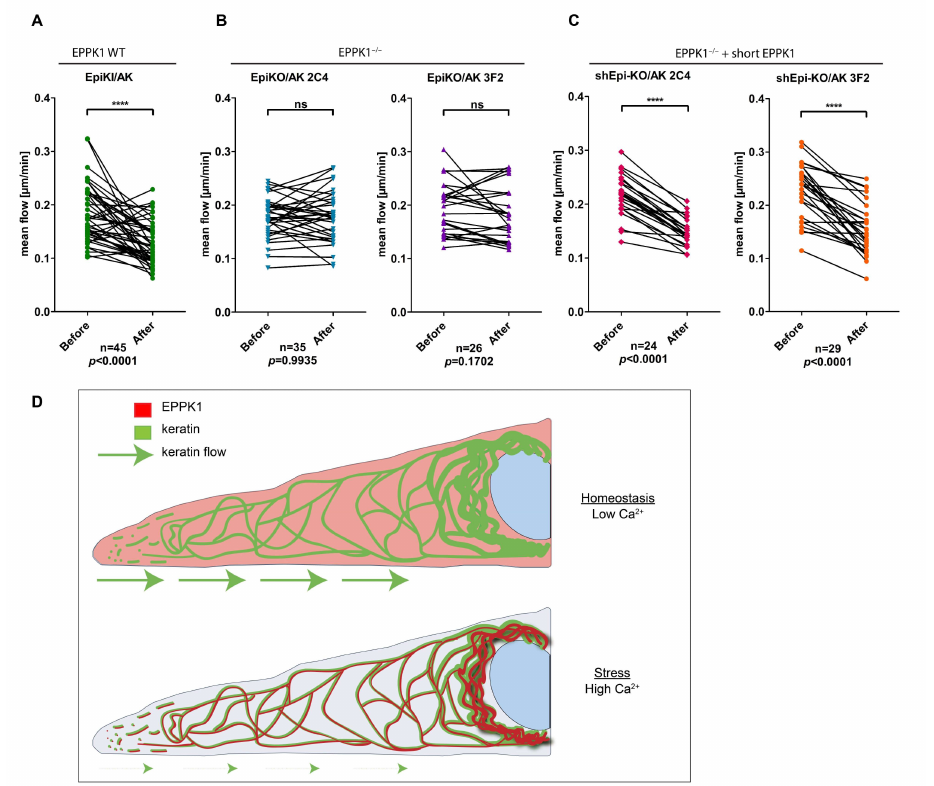
Figure 4. EPPK1-keratin association reduces the mean flow of keratins. Keratin mean flow is significantly reduced in EPPK1 WT cells expressing mScarlet-tagged endogenous EPPK1 ( A ) after